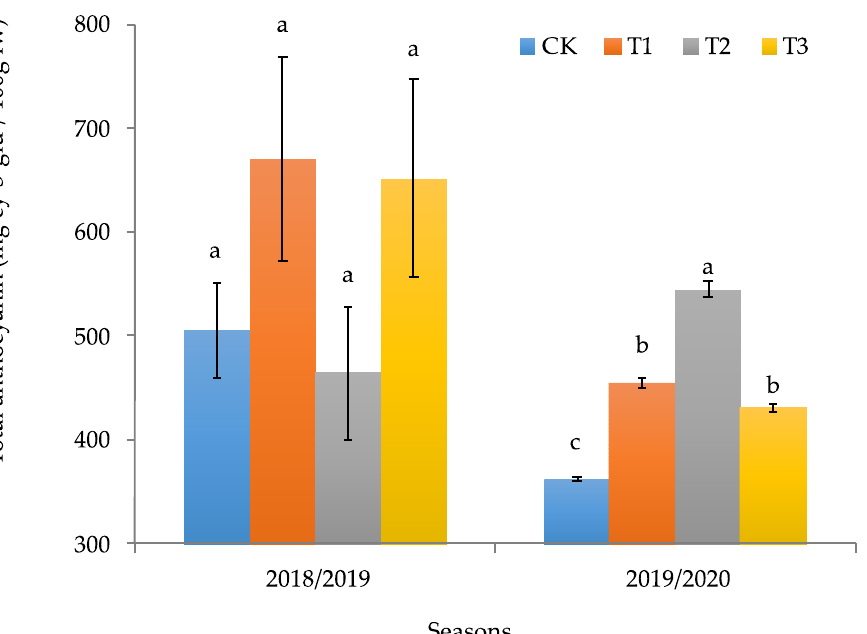
Figure 7. Effect of different doses of compost on the total anthocyanin content of the calafate fruit ( Berberis microphylla G. Forst) for the 2018–2019 and 2019–2020 seasons. CK = Control treatment (without compost application); T1 = Treatment 1 (5 Ton ha − 1 ); T2 = Treatment 2 (10 Ton ha − 1 ); T3 = Treatment 3 (15 Ton ha − 1 ). For each treatment, different lowercase letters indicate significant differences in both seasons according to Fischer’s LSD test ( p <0.05). The bars correspond to the experimental error of each treatment.